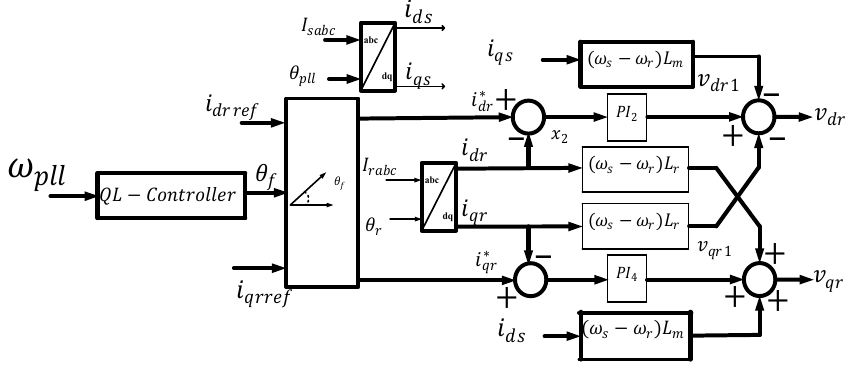
Figure 11. QL controller design on